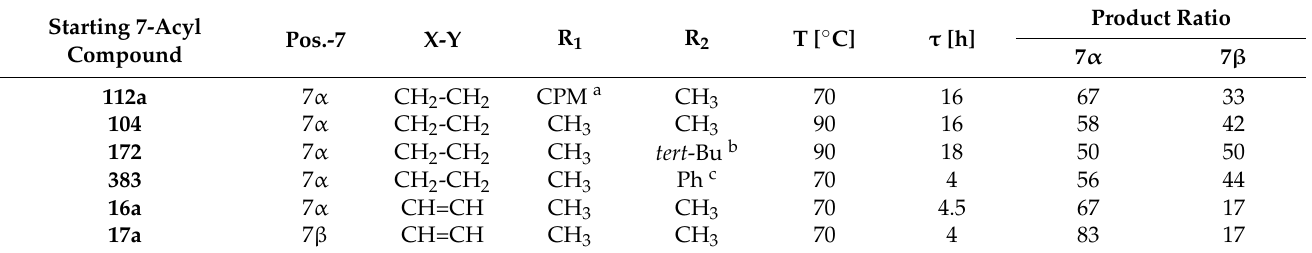
Figure 45. 7 α –7 β epimerization of 6,14-ethenomorphinans induced by perchloric acid equilibrium- enolization [155]. Table 2. Isomerization of